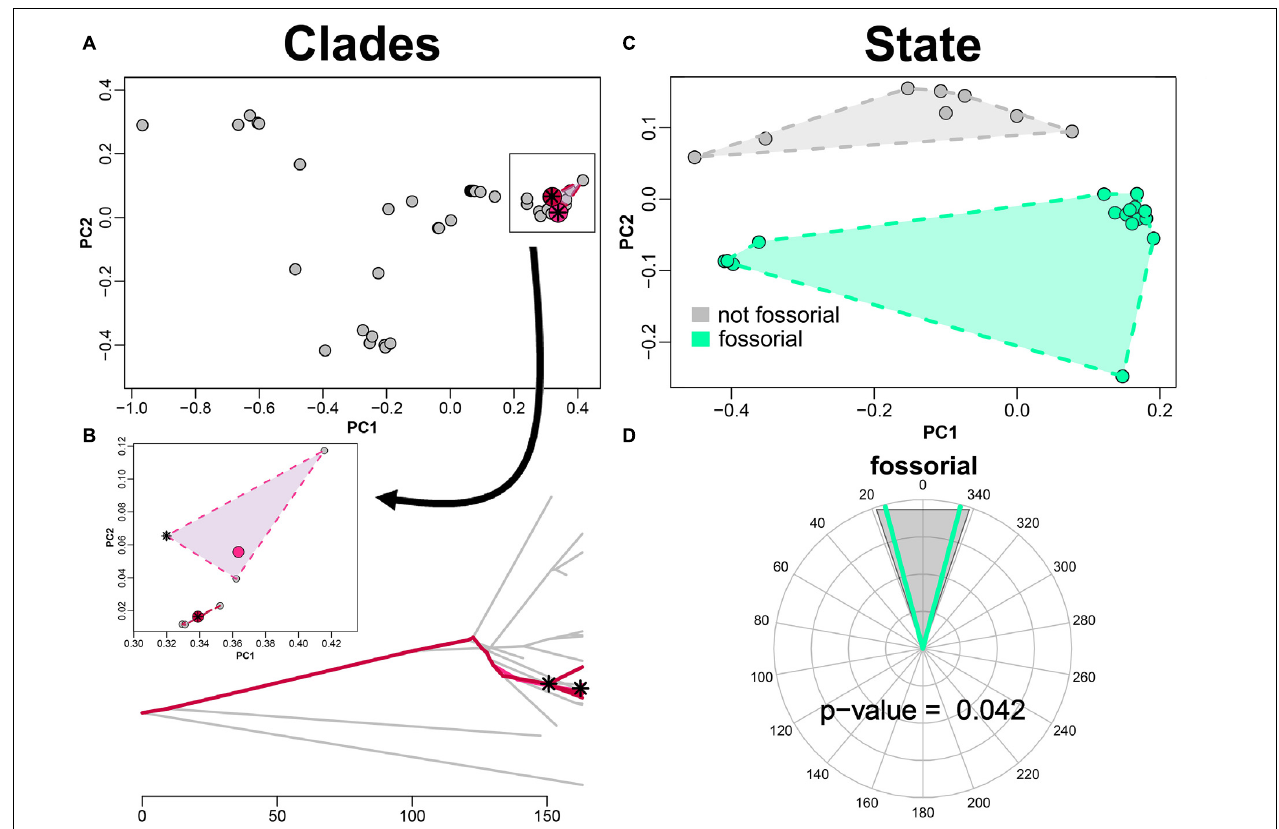
FIGURE 4 | Convergence test on fossorial mammals humeral shape. The convergence test is implemented for entire clades (A,B) and for fossorial species as they appear sparsely on the talpid tree (C,D) . PC plots appear in the upper row (A,C) . (B) phenogram describing the path of the convergent clades. (D) angle between the fossorial species as compared to the random distribution of angles obtained shuffling the states across species in the tree. The asterisks represent the ancestral states of the clades found to converge. The pink and purple dots represent the mean phenotype of the species within the respective clades found to